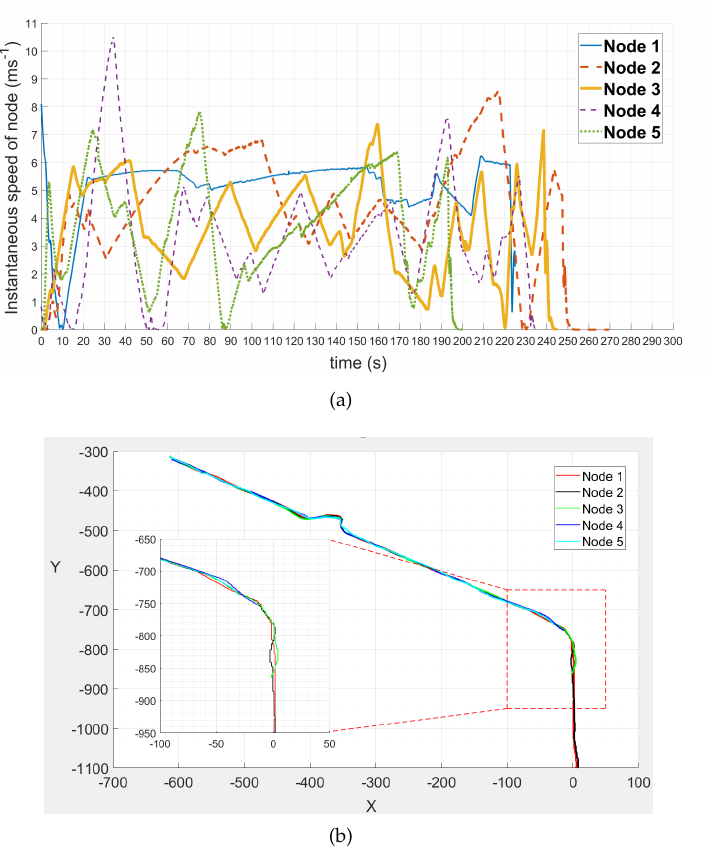
Figure 14. The movements for five nodes. ( a ) Instantaneous speeds of five nodes over time. ( b ) Trajectories of five